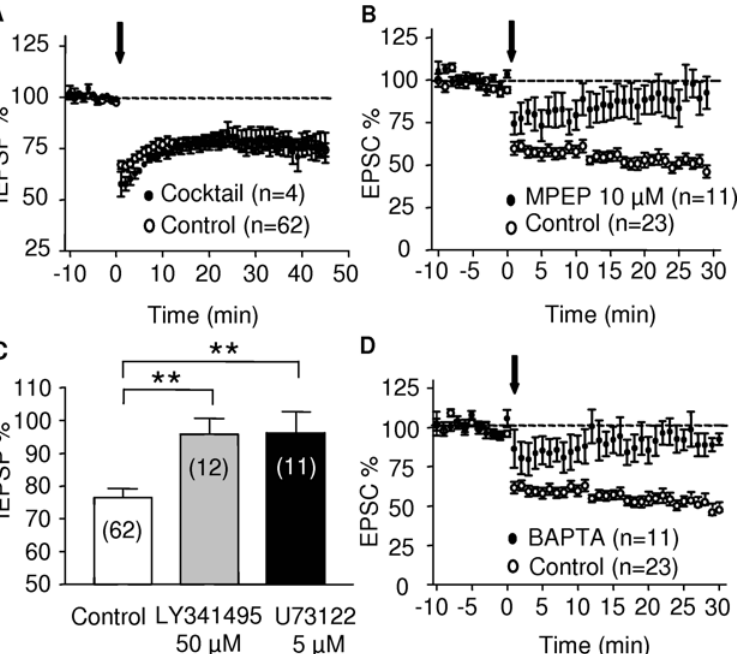
Figure 5. Postsynaptic receptors and transduction pathways involved in eCB-LTD. (A) eCB-LTD was not affected by a mixture of the NMDAR antagonist MK801 (40 m M), the D1 receptor antagonist SCH23390 (25 m M) and the D2 receptor antagonist sulpiride (25 m M). (B) The mGluR5 antagonist MPEP (10 m M) completely blocked eCB-LTD (C) Bar graph summarizing experiments showing that the non subtype selective group 1mGluR antagonist LY341495 (50 m M) and the Phospholipase C inhibitor U73122 both prevented eCB-LTD induction. 45 min after the end of the tetanus, the fEPSPs was 76.6 6 2.64% (n=62) of baseline in control and 95.8 6 4.85% (n=12, p=0.004 t-test) and 96.33 6 6.4% (n=11, p=0.0009 t-test) in LY341495, respectively. (D) eCB-LTD requires postsynaptic Ca 2 + rise. Time course of all the experiments performed where the recording pipette was filled with BAPTA (20 mM, n=11) and where eCB-LTD was completely blocked.